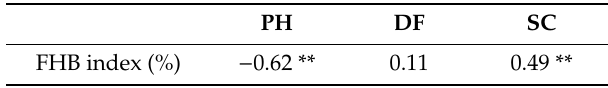
Table 4. Correlations between FHB index and plant height (PH), days to flowering (DF), and spike compactness (SC) in the Jingzhou66 × Aikang58 DH population.